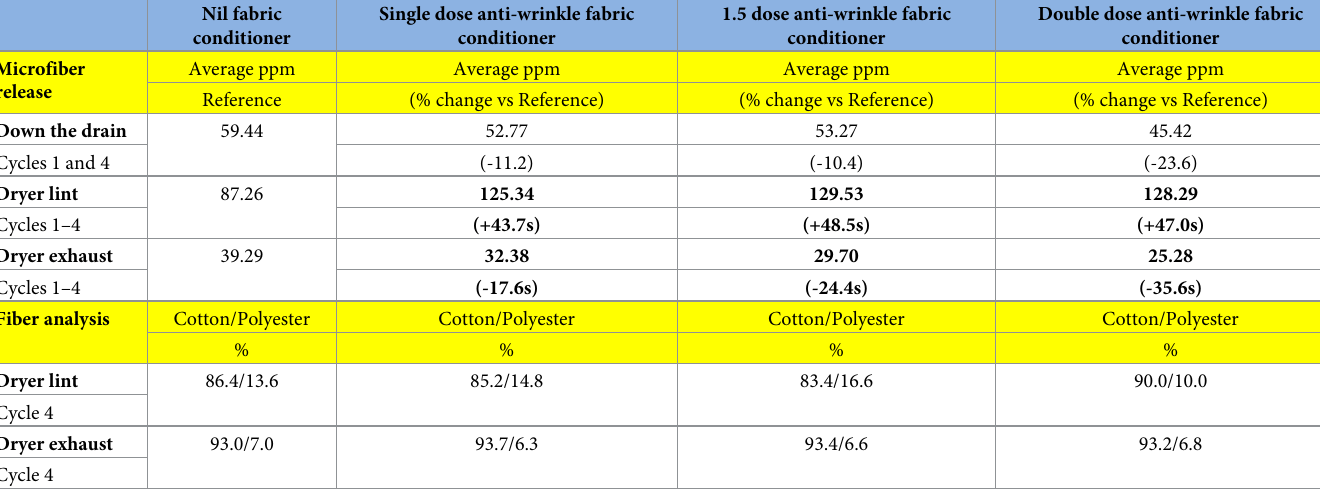
Table 3. Summary of microfiber release and fiber analysis data–North America liquid anti-wrinkle fabric conditioner